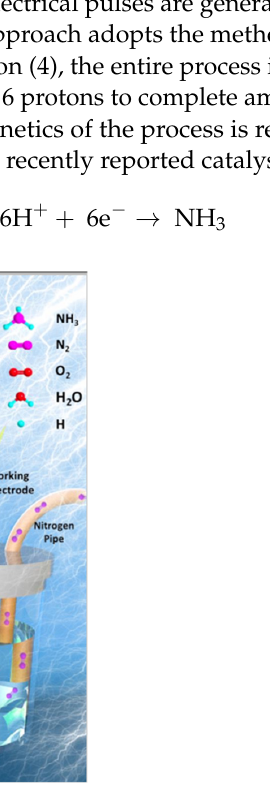
Figure 1. Schematic Diagram of NRR system [25].